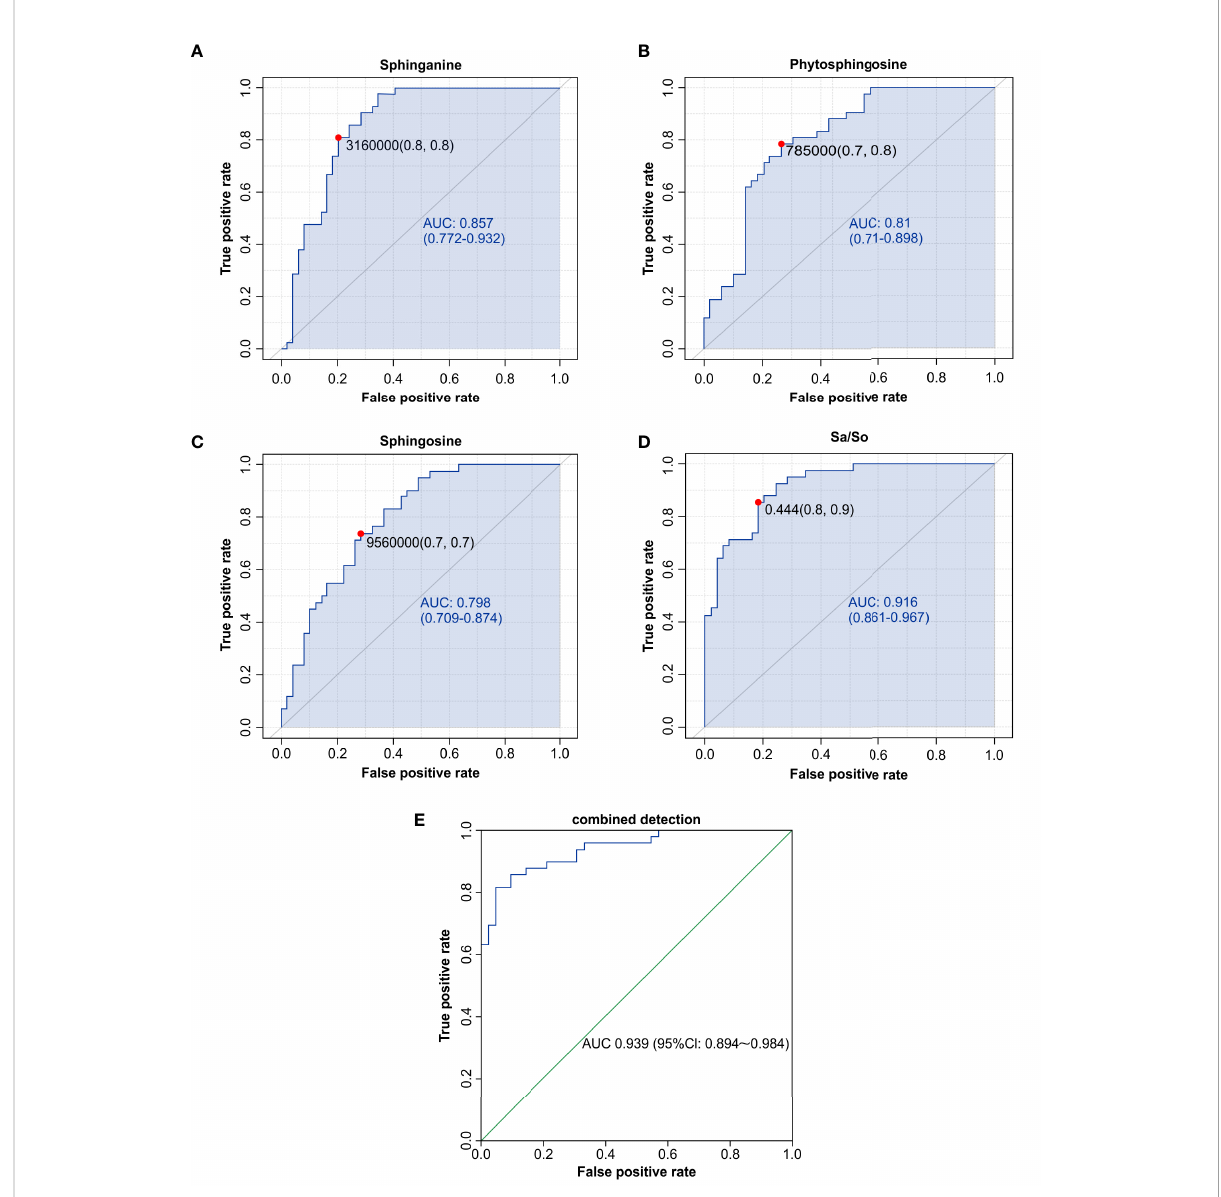
FIGURE 7 Sphingolipid metabolites, such as sphinganine (A) , phytosphingosine (B) , sphingosine (C) , the Sa/So ratio (D) , and the combination of multiple indicators (E) , were discovered to have high AUCs by ROC analysis and could be used as biomarkers for in fl uenza-induced pneumonia in children. AUC, area under the curve; ROC, receiver operating